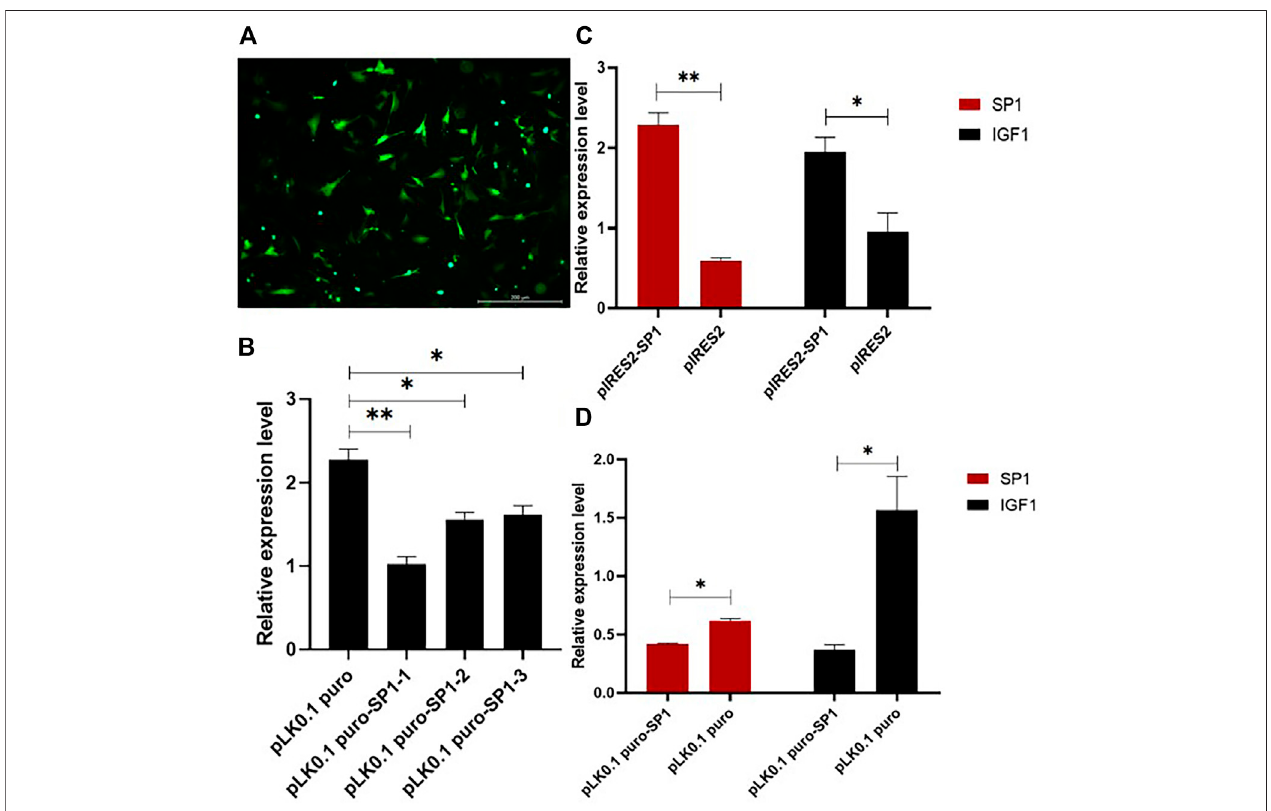
FIGURE 4 | Transcription factor SP1 affects the expression of IGF1 . (A) Transfection ef fi ciency of the vector in granular cells. (B) Three SP1 interference ef fi ciency graphswererepresentedusingRT-qPCRtodetecttheexpressionlevelofSP1. (C,D) SP1overexpressionandinterferencevectorsweretransfectedintogoatgranulosa cells, and the expression levels of SP1 and IGF1 were detected by RT-qPCR. Bars represent the mean ± SEM of at least three repeats. * p < 0.05, ** p < 0.01.